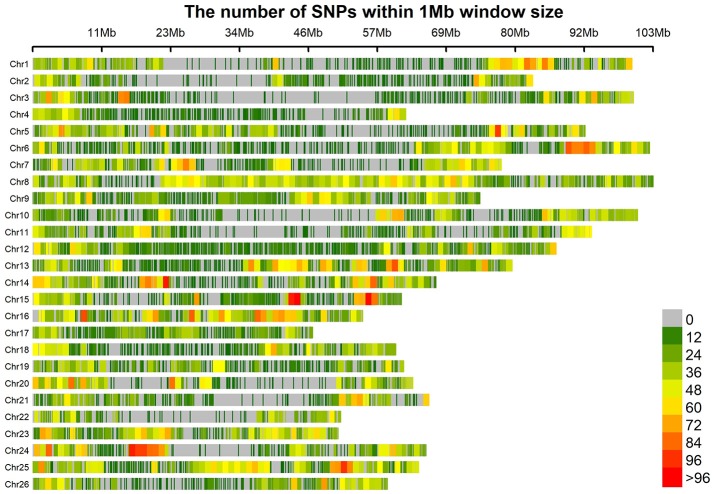
Distribution of 41815 SNPs on the 26 chromosomes of upland cotton. The horizontal axis shows chromosome length (Mb); the different colors depict SNP density (the number of SNPs per window).